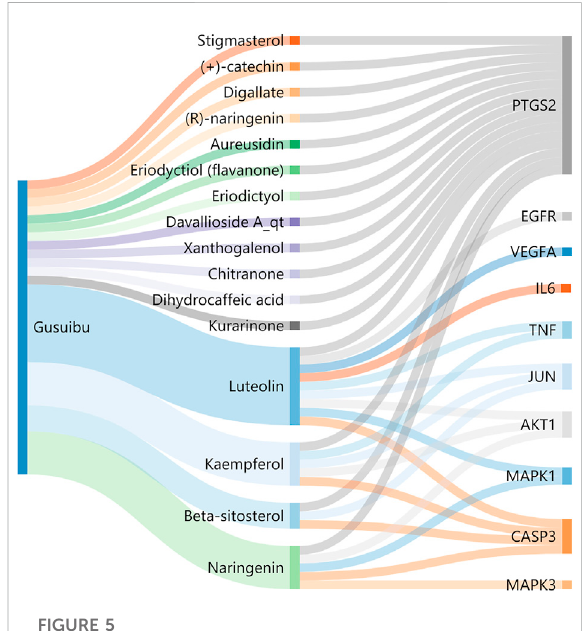
FIGURE 5 Sankey diagram. The blue vertical bar on the left represents Gusuibu, the middle bars represent the active ingredients of Gusuibu, and the right bars represent the top 10 hub genes. The size of the bars represents the number of